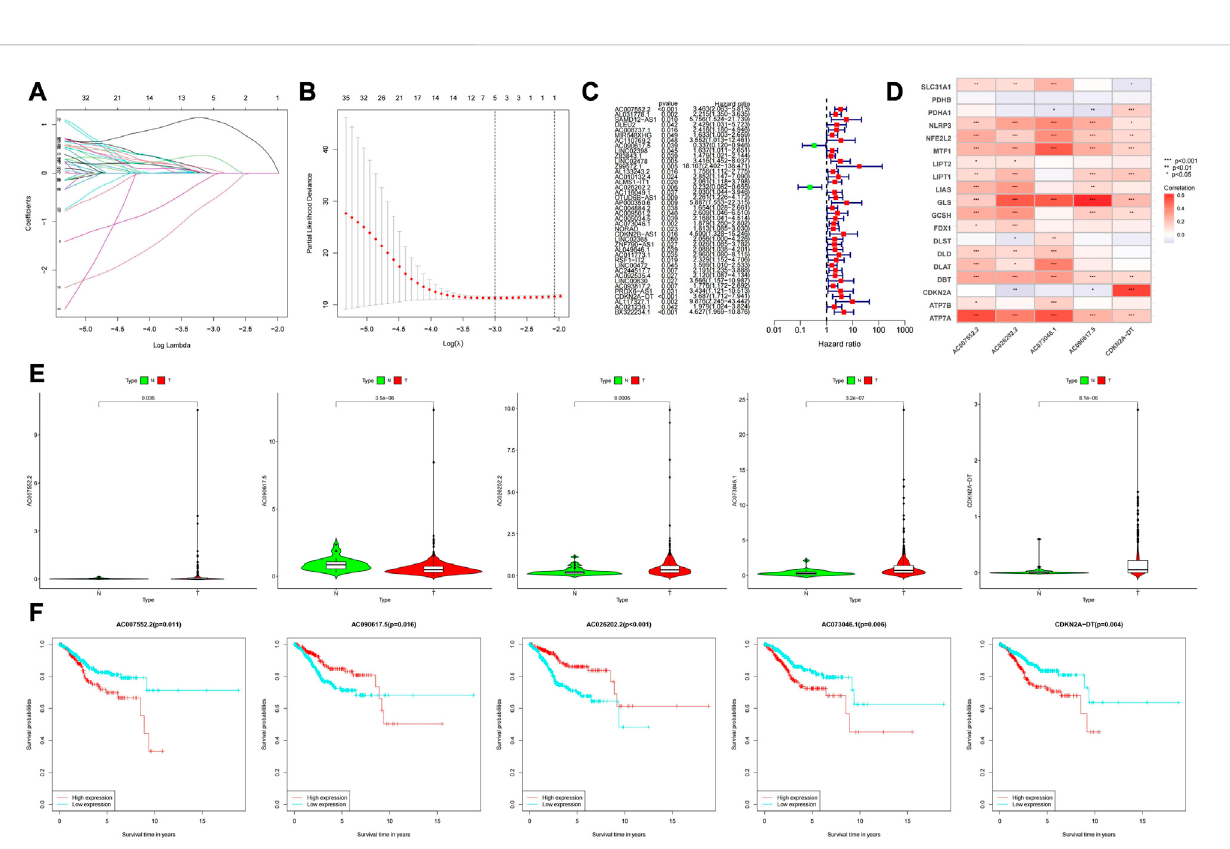
FIGURE 3 (A,B) LncRNAs screened by the LASSO-Cox regression model. (C) The green marks represent low-risk LncRNAs, and the red marks represent high- risk LncRNAs. (D) Relationship between cuproptosis-related genes and LncRNAs. (E) Expression levels of the 5 LncRNAs in tumor and normal tissues. (F) Prognostic value analysis of the 5